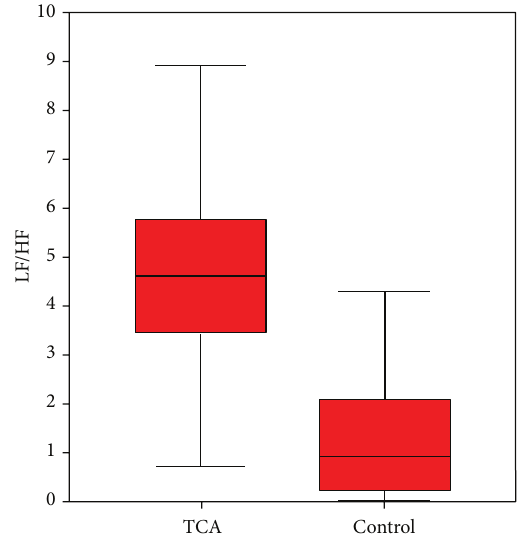
Figure 1: Comparison of the LF/HF ratio within the first 5 minutes between children with TCA intoxication and controls.